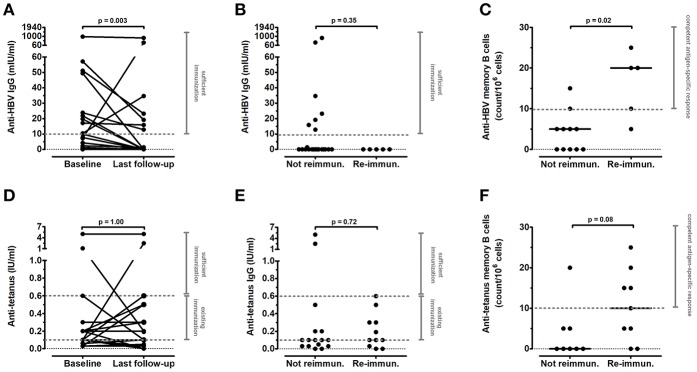
Long-term effects of anti-CD20 treatment on vaccine competence in children with INS. Antigen-specific IgG titers and memory B cells against (A–C) hepatitis B virus (HBV) and (D–F) tetanus were determined in INS pediatric patients before and after anti-CD20 treatment. (A,D) IgG titers compared between baseline and last follow-up (n = 27). (B,E) IgG titers at last follow-up comparing re-immunized (n = 5 against HBV and n = 11 against tetanus) vs. not re-immunized patients. (C,F) memory B cells evaluated by fluorospot analysis at last-follow-up (n = 17) comparing re-immunized (n = 5 against HBV and n = 9 against tetanus) vs. not re-immunized patients. Each plot represents a different patient. Protective levels identified by dashed gray lines were indicated in the diagnostic laboratory of our Institution. Differences between groups were compared using the non-parametric paired Wilcoxon signed-rank test or non-parametric unpaired Mann-Whitney U test, as appropriate.